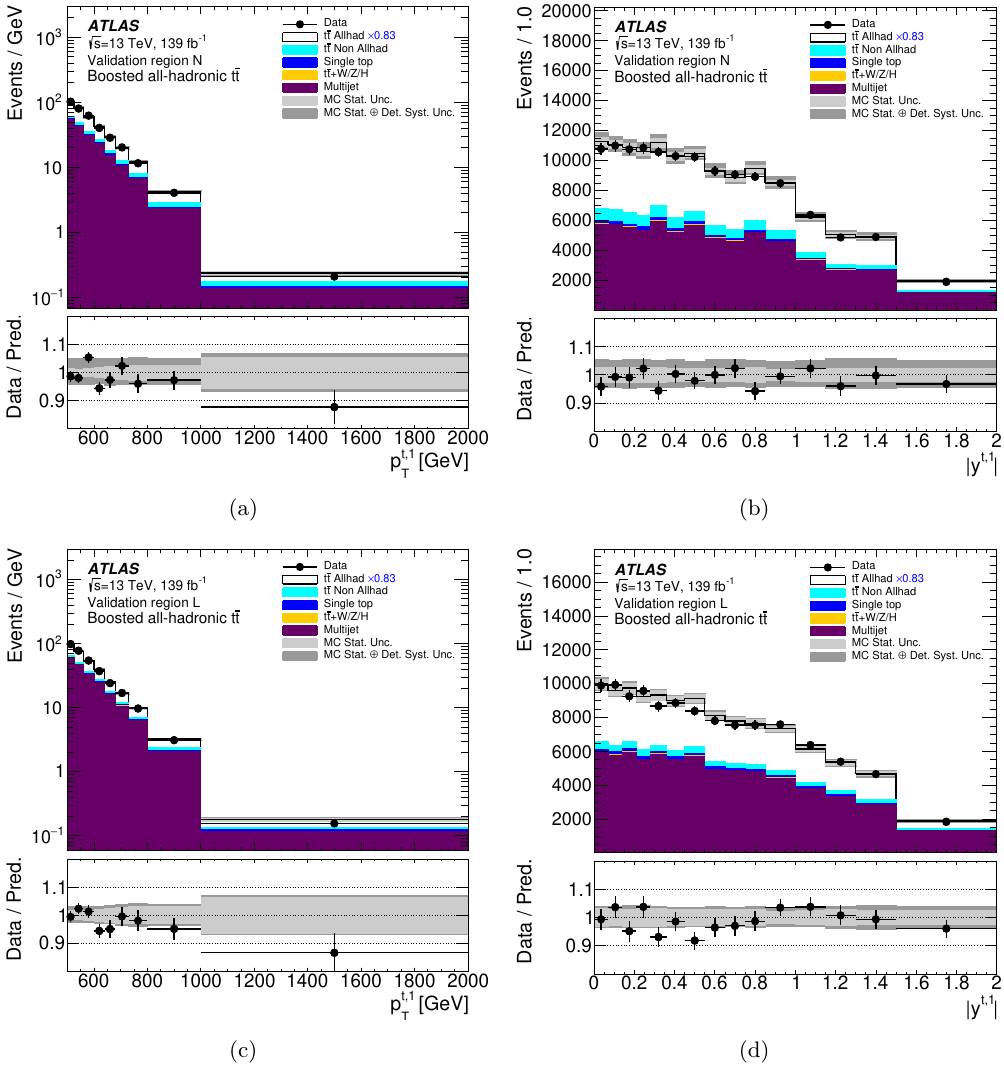
Figure 3 . Kinematic distributions of the leading top-quark-candidate jets in validation regions N and L: (a) and (b) are distributions of the leading large- R jet p T and the absolute value of the rapidity in region N, respectively, and (c) and (d) are the distributions of the leading large- R jet p T and absolute value of the rapidity in region L. The signal prediction (open histogram) is based on the Powheg + Pythia 8 t ¯ t calculation normalized to the observed yield in a signal region. The background (solid histogram) is the sum of the data-driven multijet estimate and the MC- based expectation for the contributions of non-all-hadronic t ¯ t , single-top-quark, and t ¯ t + W/Z/H processes. The light grey bands indicate the statistical uncertainties and the dark grey bands indicate the combined statistical and detector-related systematic uncertainties defined in section